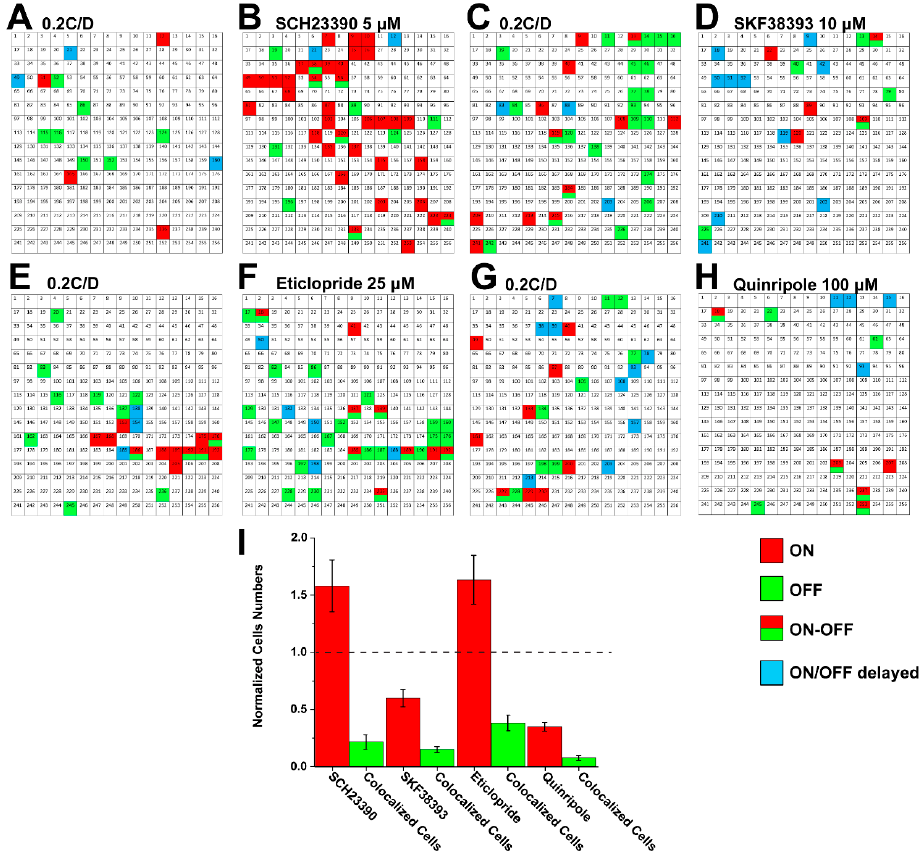
Figure 4. Map of firing pattern changes under dopamine receptors 1 and 2 agonist and antagonist applications in the mouse retina: D1R antagonism SCH23390 5 µM ( A,B ) increased firing cell